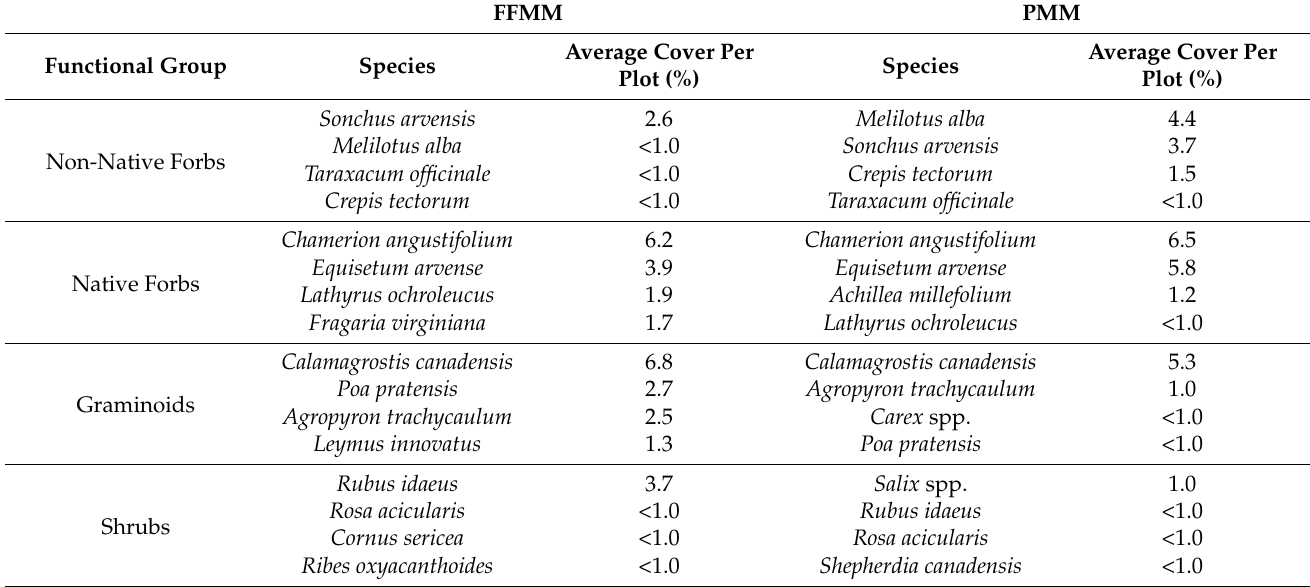
Table 2. Four species with the highest average percent cover per plot found within each functional group and soil type showing cover